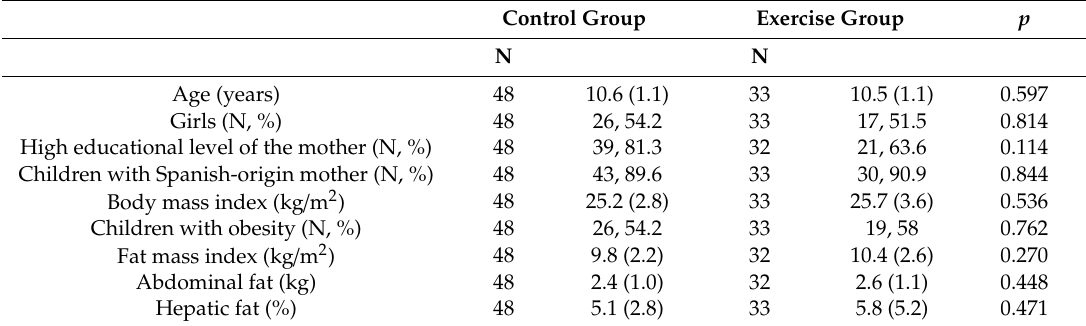
Table 1. Baseline biological and sociodemographic characteristics of study participants according to the intervention